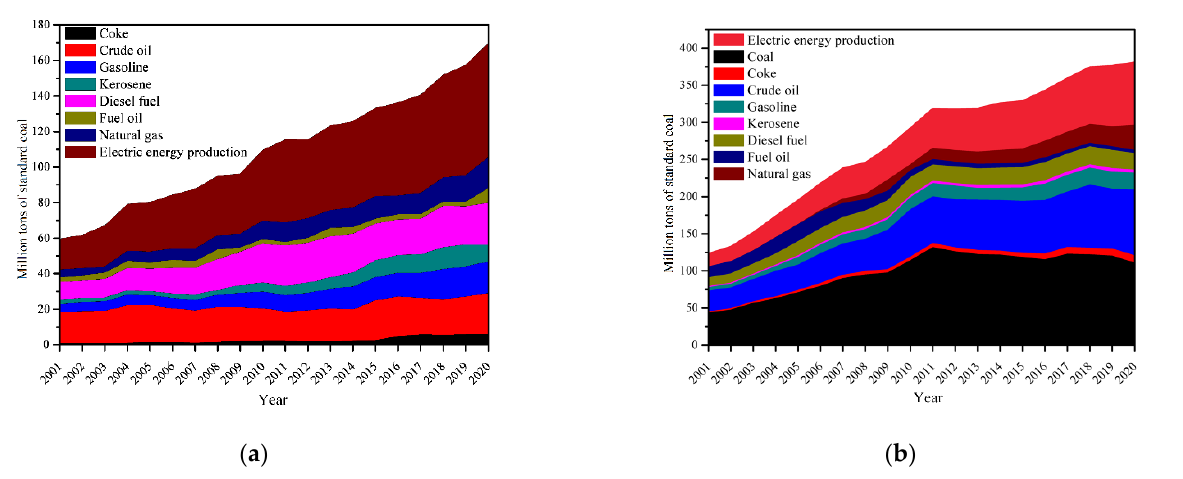
Figure 3. Rural energy consumption structure in Guangdong, ( a ) Rural household energy consump- tion structure; ( b ) Rural import energy consumption structure. From Guangdong Statistical Year- book (2007–2020) [16]; China Energy Statistical Yearbook (2007–2020) [14].